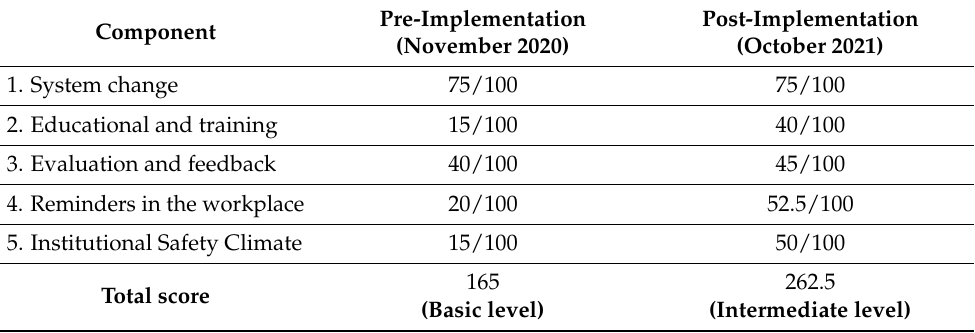
Table 3. Hand hygiene self-assessment framework scores before and after implementing the Safe- HANDS